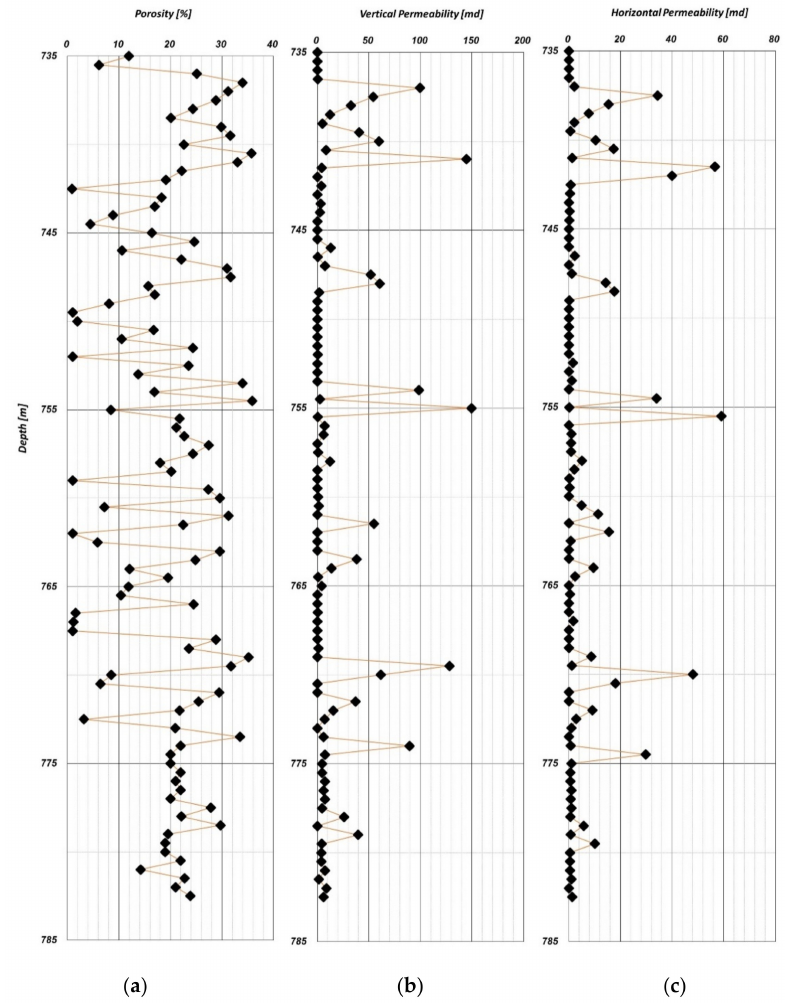
Figure 10. Petrophysical model between 735 and 785 m for ( a ) porosity, ( b ) vertical permeability, and ( c ) horizontal permeability. Table 1. Mean and variance in petrophysical properties for each facies, including porosity, vertical permeability, and horizontal